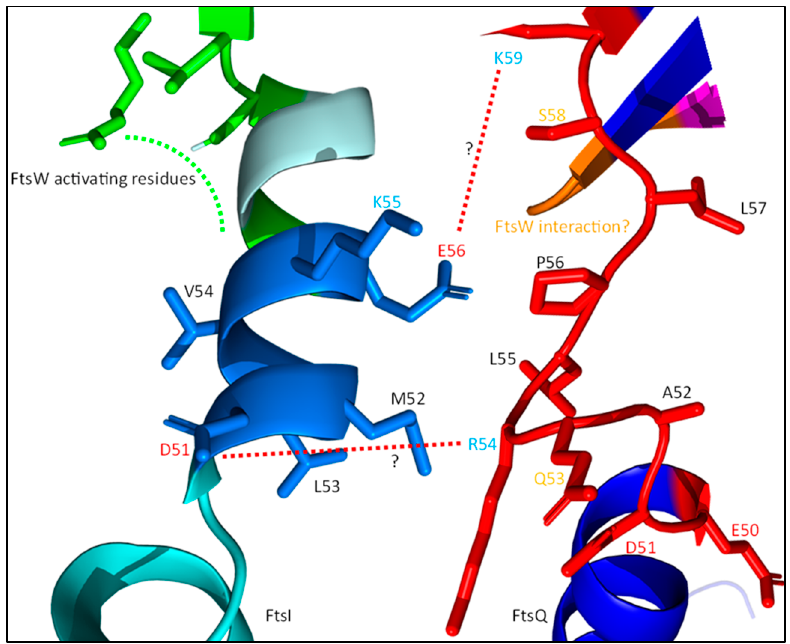
Figure 14. Potential FtsQ–FtsI interactions. The potential FtsQ–FtsI interaction interface described in Table 2 is shown here in the predicted structures of FtsI and FtsQ. The FtsI region forms a helix, while the FtsQ region is an unstructured loop. Possible regulating interactions have been indicated with the red lines and the FtsW-activating residues of FtsI in green. Table 2. FtsQ–FtsI interaction region.